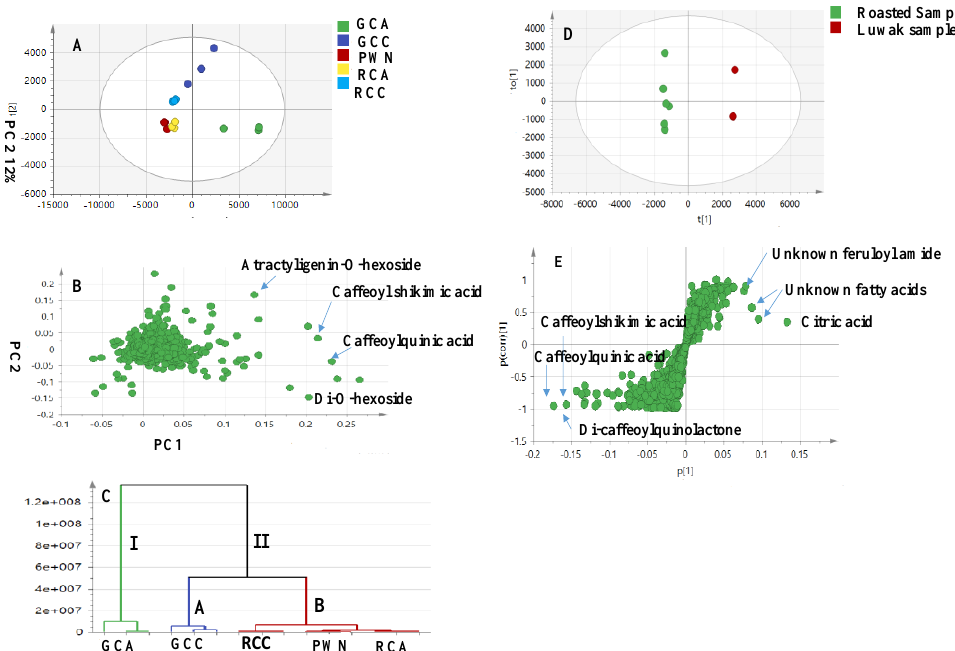
Figure 4. ( A ) Principal component analysis (PCA) score plot of PC1 vs. PC2 scores, based on the UPLC-MS of authentic samples (arabica and canephora specimens) and Luwak samples. ( B ) PCA loading plot for PC1 and PC2, showing the potential markers for roasted coffee seeds. ( C ) HCA of the authentic and Luwak samples. ( D ) OPLS-DA score plot for the Luwak versus the roasted samples only. ( E ) OPLS-DA S-plot for the Luwak versus the roasted samples that are contributing markers for Luwak coffee. OPLS-DA-S-plot models show the covariance- p [1] against the correlation p (cor) [1] for the variables of the discriminating components of the OPLS-DA models. Cut-off values of p < 0.05 were used; selected variables are highlighted in the S-plot and are discussed in the text.